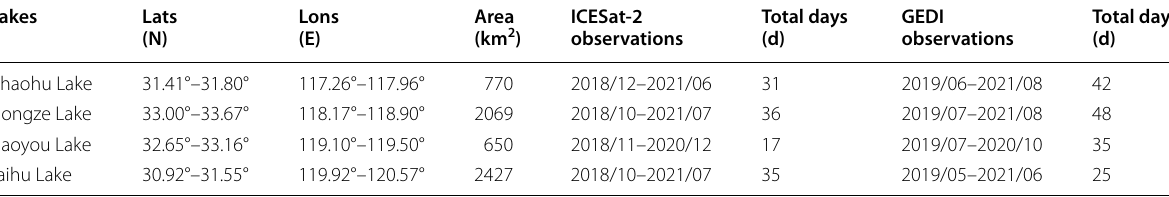
Notes: the water surface area of each lake is under its normal water level